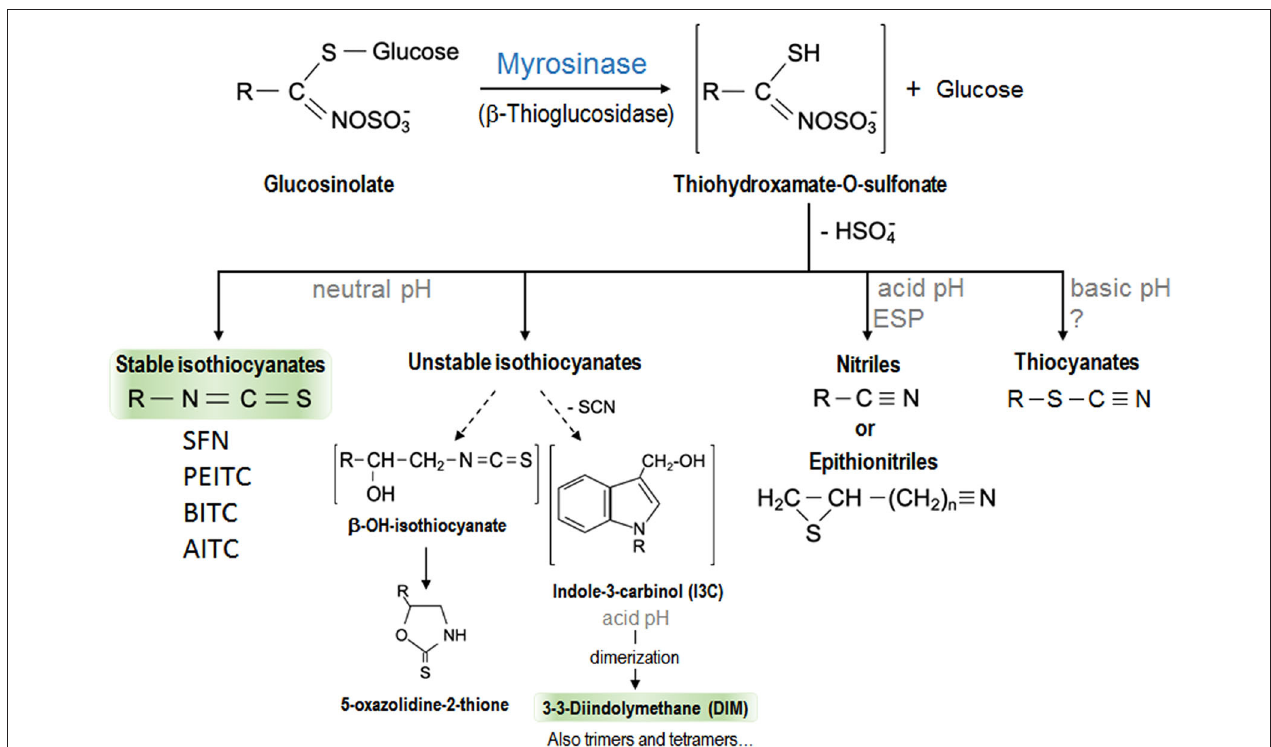
FIGURE 1 | Scheme of the hydrolysis of glucosinolates by myrosinase enzyme with the resulted isothiocyanates and other derivatives. The biologically active hydrolysis products of glucosinolates, better studied and discussed in this review have been highlighted. EPS, epithiospecifer